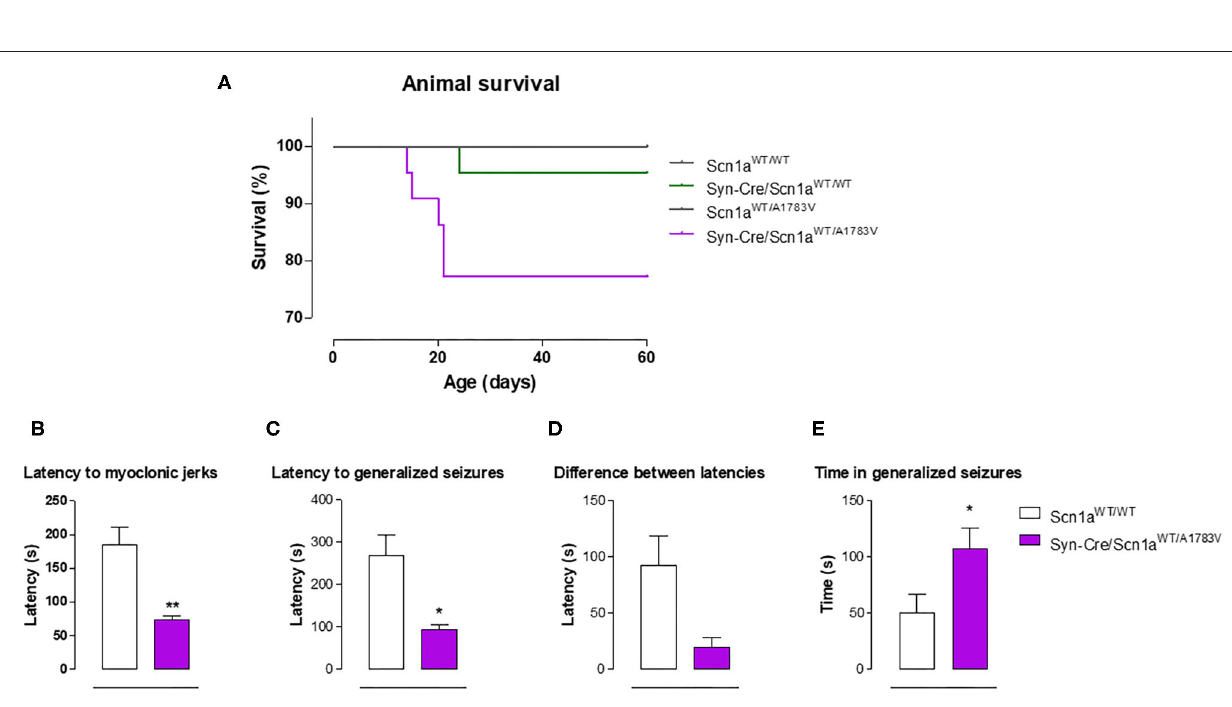
FIGURE 5 | Animal survival in Syn-Cre/Scn1a WT / A1783V mice and their three control groups (Scn1a WT / WT , Syn-Cre/Scn1a WT / WT , and Scn1a WT / A1783V mice), and seizuring activity in Syn-Cre/Scn1a WT / A1783V mice compared with Scn1a WT / W animals after an acute injection of PTZ at PND25 (lower panels). Values are means ± SEM of six to eight animals per group. Data were assessed by Kaplan-Meier analysis (survival data) and by the Student’s t -test (PTZ experiment; * p < 0.05, ** p < 0.01 vs. the control